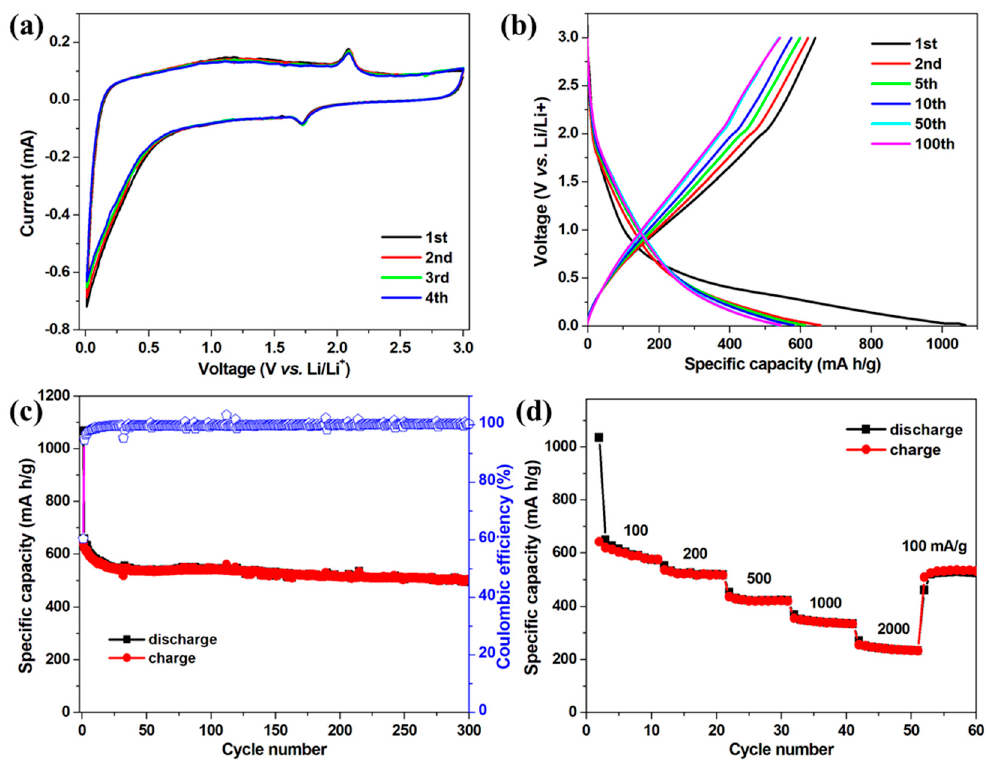
Figure 4. ( a ) CV curves at a scan rate of 0.1 mV/s; ( b ) galvanostatic discharge-charge profiles at 100 mA/g; ( c ) cycle performance at 100 mA/g; and ( d ) rate performance of TSC nanofibers at different current densities.